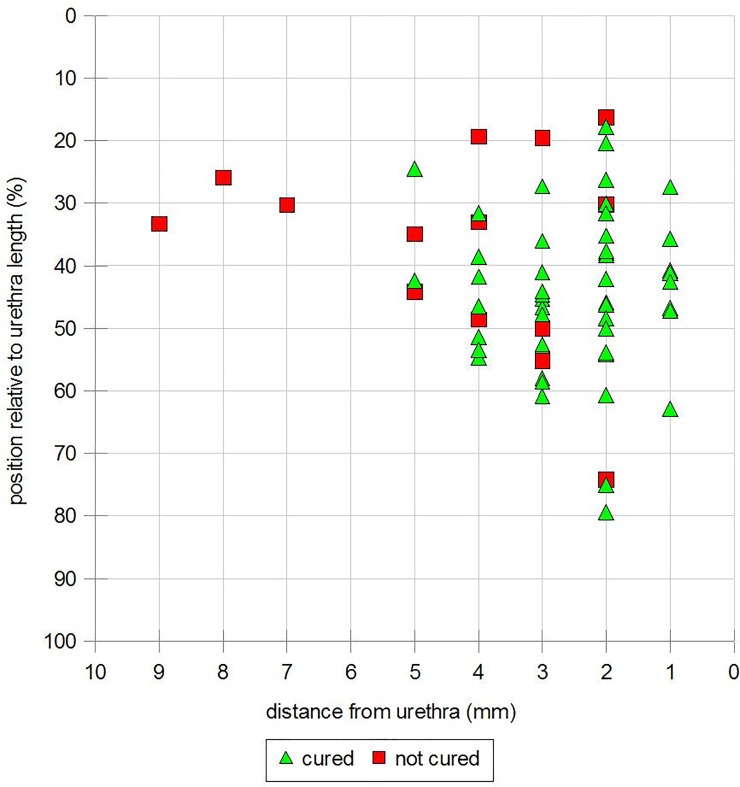
Cured vs. none-cured women according to the stress cough test dependent on tape position relative to TUD and TP.